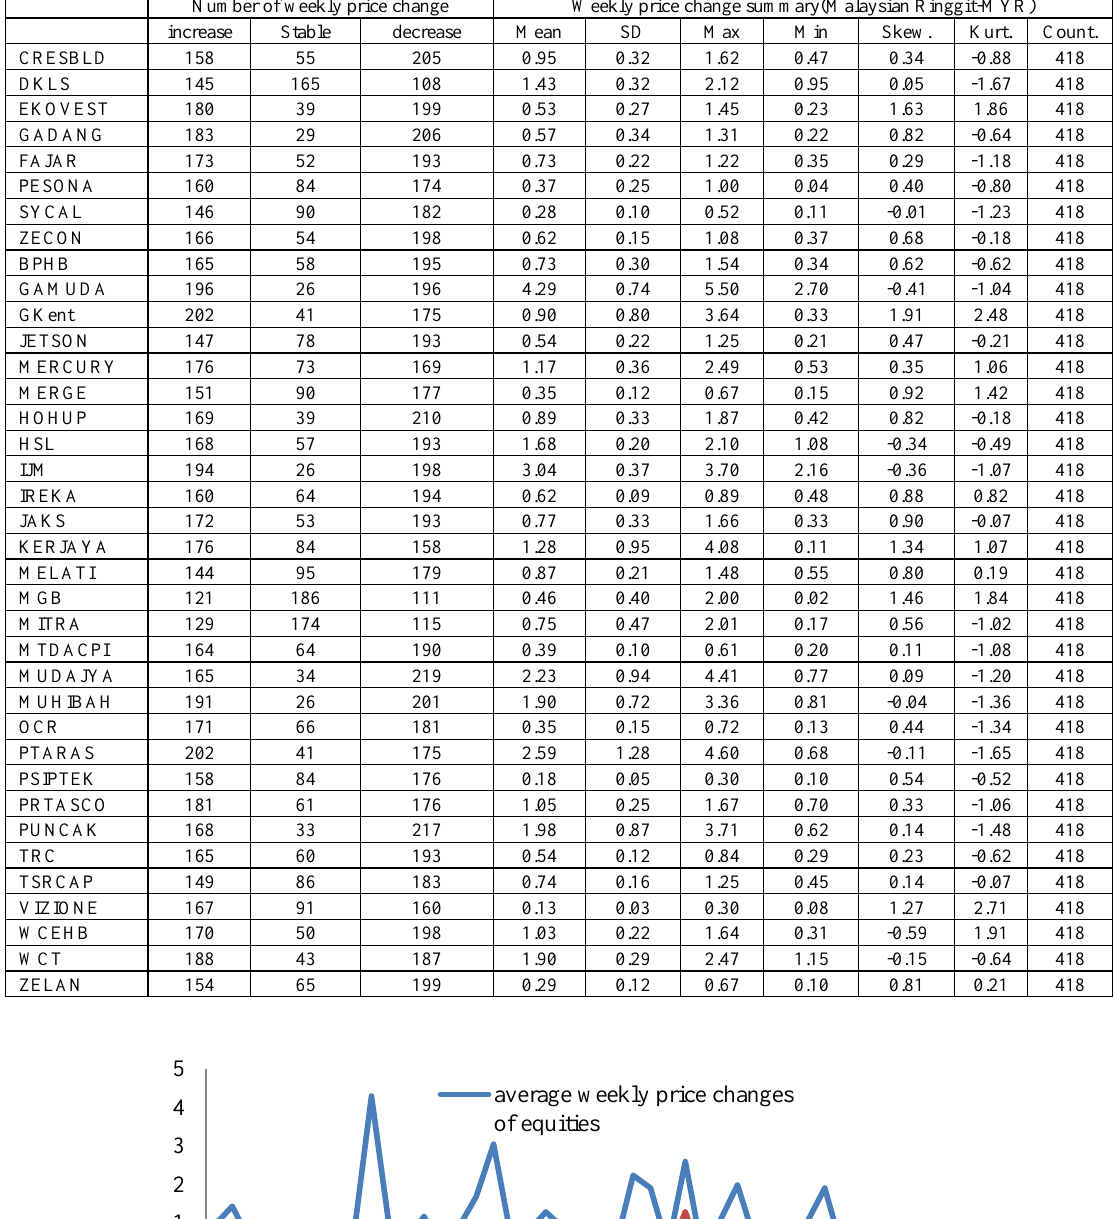
Table 1. Summary statistics on the weekly trading price change over the study period Number of weekly price change Weekly price change summary(Malaysian Ringgit-MYR) increase Stable decrease Mean SD Min Skew. Kurt. Count.